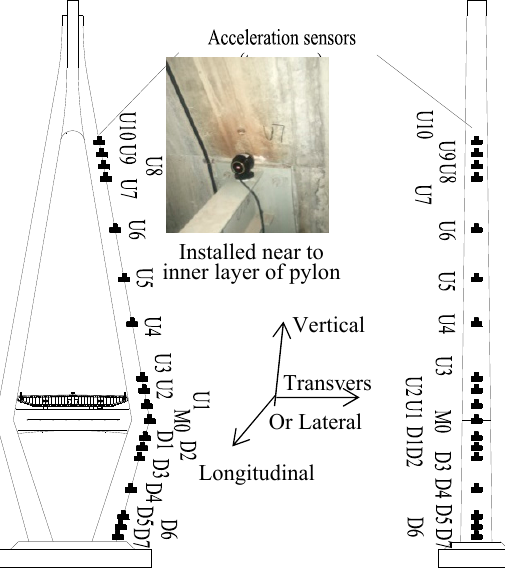
Figure 5. Arrangement of transverse acceleration sensors along the pylon.